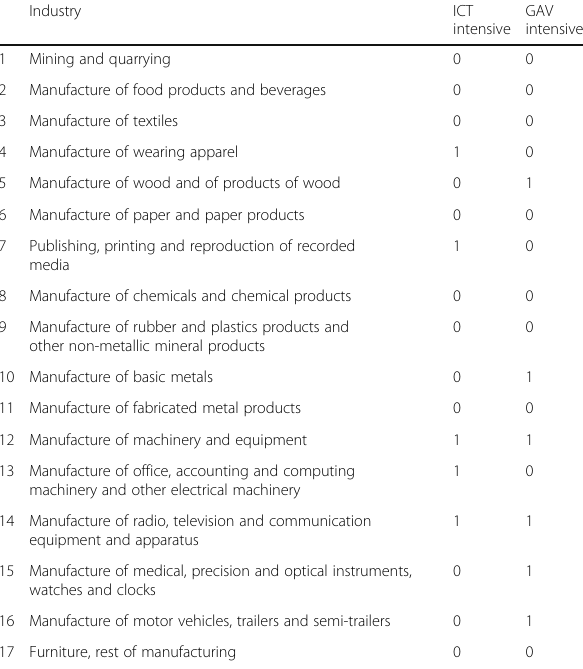
Table 5 Industry dummies for ICT intensity and GAV intensity